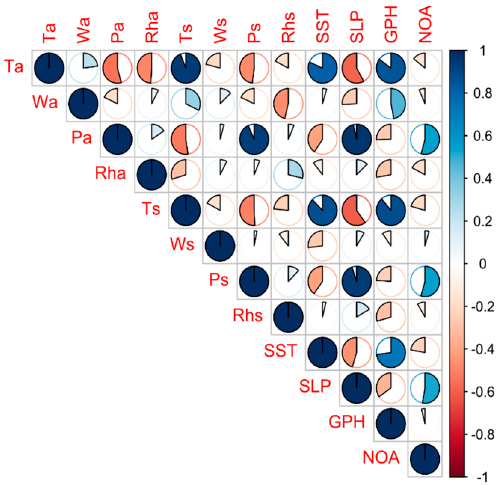
Figure 6. Identification of highly correlated predictors (conf. level = 0.95). It shows the between- predictor correlations of the transformed continuous predictors; there are many strong positive correlations (indicated by large, dark blue circular sector).